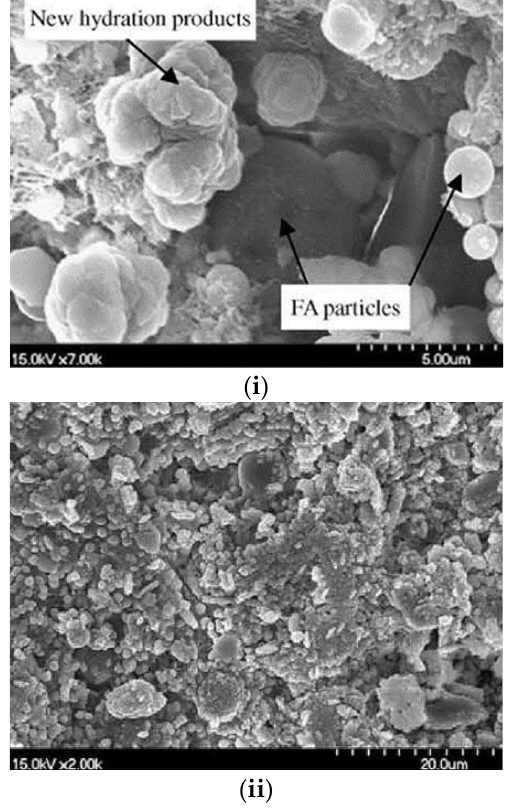
Figure 23. Surface microstructure of the old concrete after fly ash implementation: ( i ) 1 day; ( ii ) 3 days [44]. Reproduced with permission from [44], Elsevier, 2010.